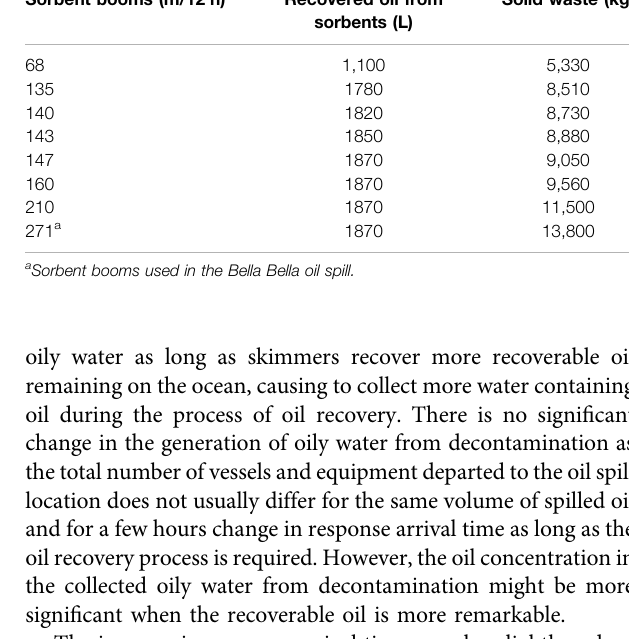
TABLE 5| Sensitivity analysisoftheeffect ofsorbentbooms onrecovered oilfrom sorbents and solid waste. Sorbent booms (m/12